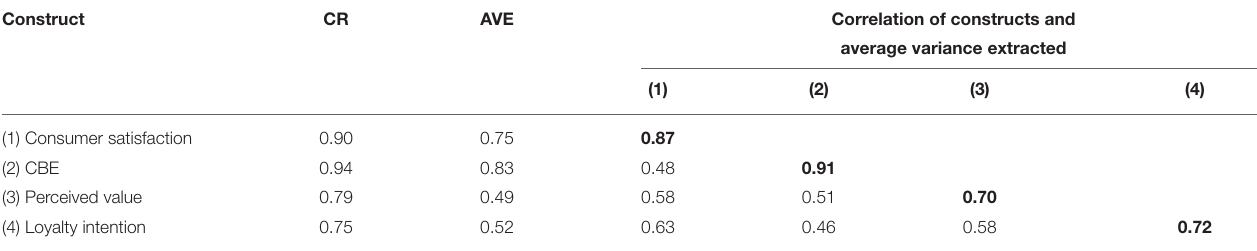
TABLE 3 | The convergent and discriminant validity indices of the measurement model. Construct CR AVE Correlation of constructs